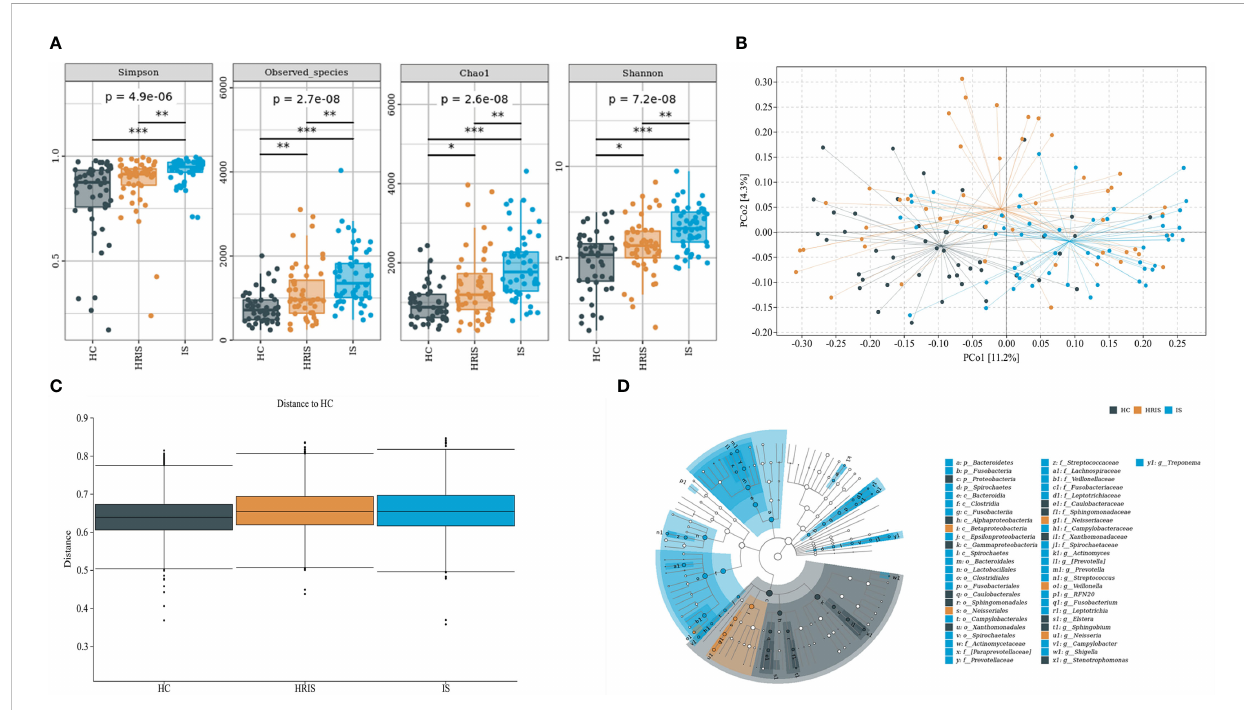
FIGURE 3 Oral microbiota composition of subjects with IS, HRIS and HC. (A) Comparison of a -diversity between the oral microbiota in three groups. (B) Principal coordinate analysis based on the unweighted UniFrac distances. (C) Unweighted UniFrac distances of each subgroup of control compared with HC. (D) linear discriminant analysis effect size-determined differential